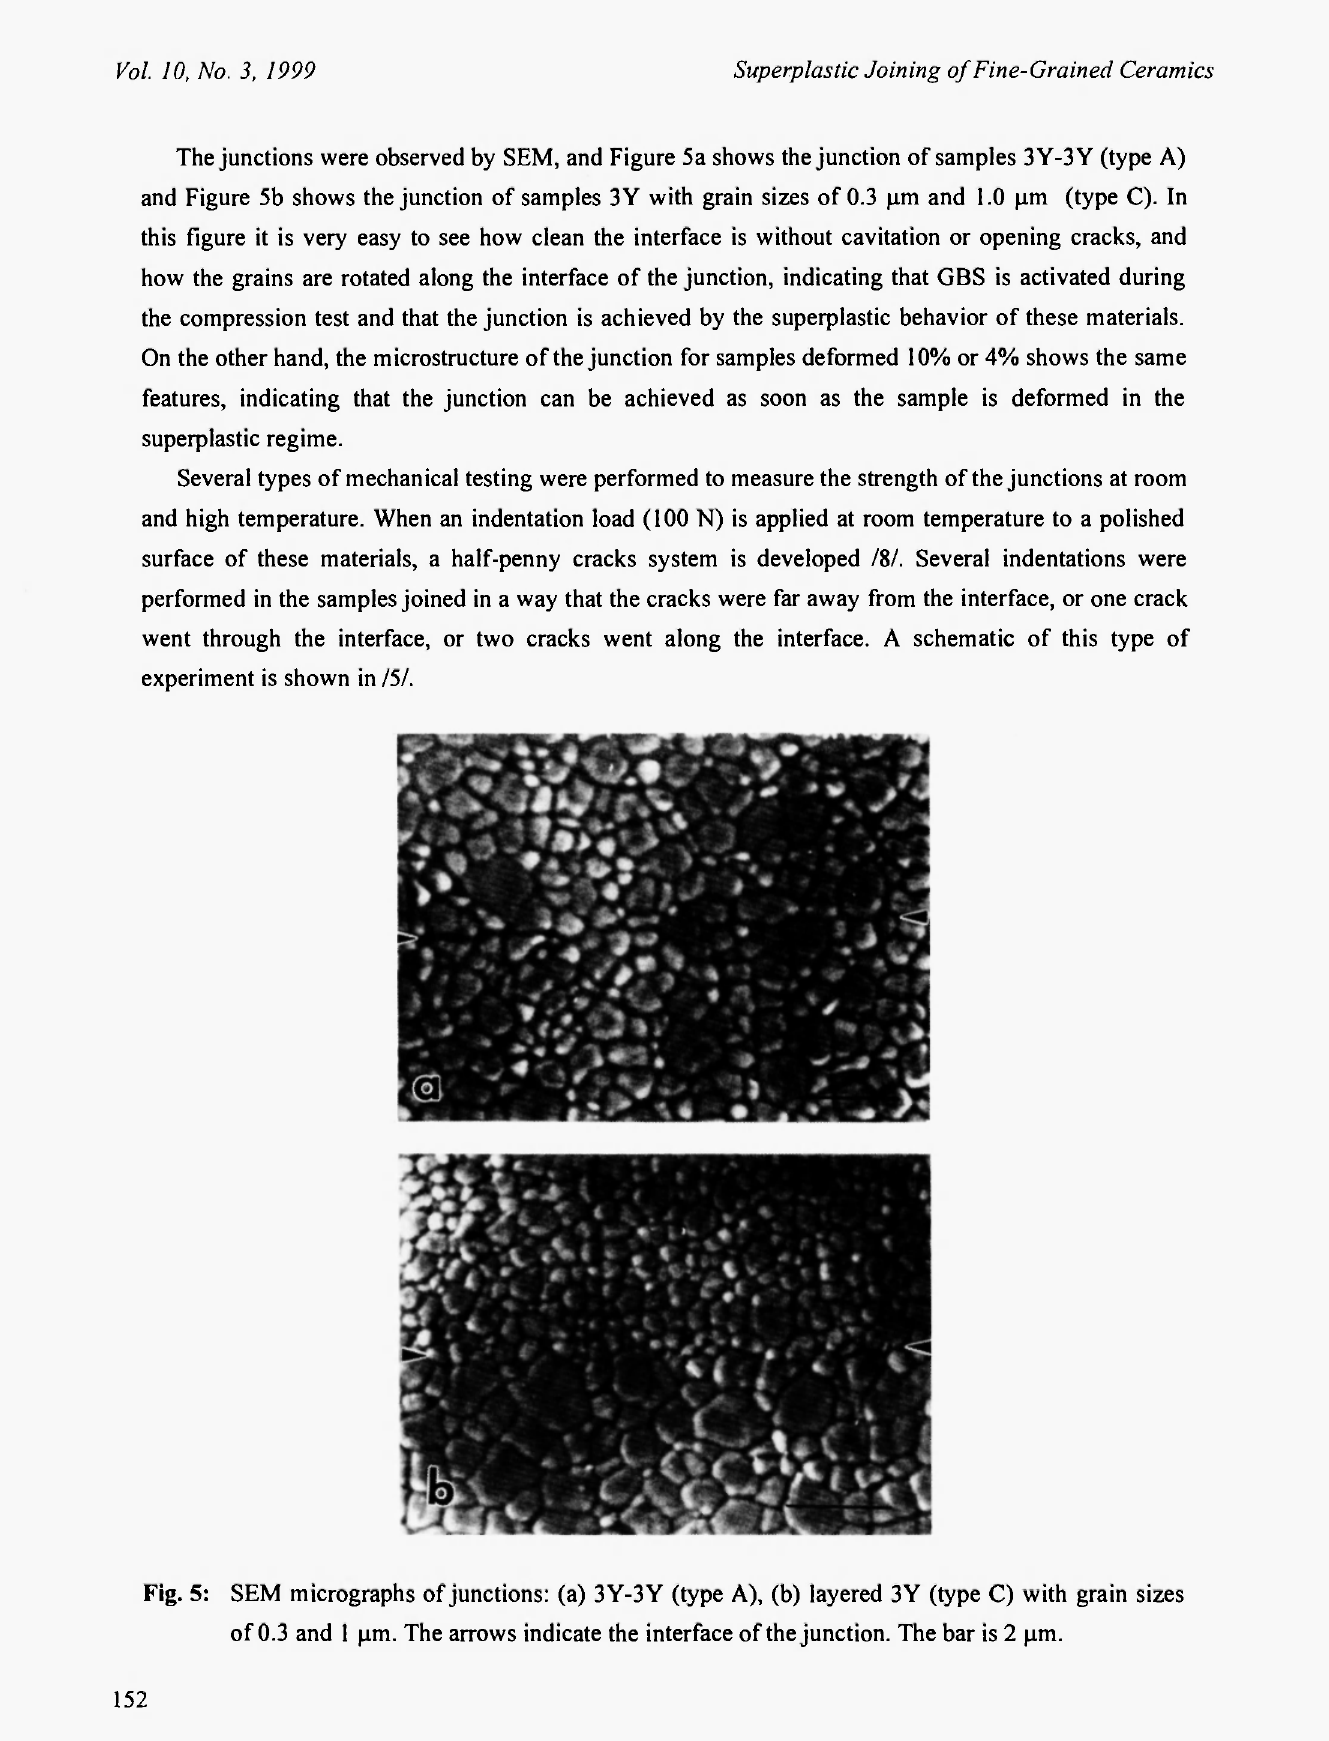
Fig. 5: SEM micrographs of junctions: (a) 3Y-3Y (type A), (b) layered 3Y (type C) with grain sizes of 0.3 and 1 μηι. The arrows indicate the interface of the junction. The bar is 2 μηι.